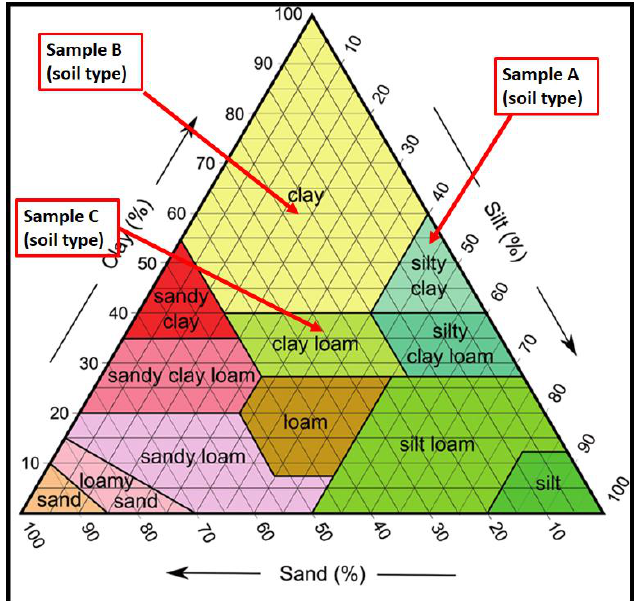
Figure 8. Soil texture chart of the study area.